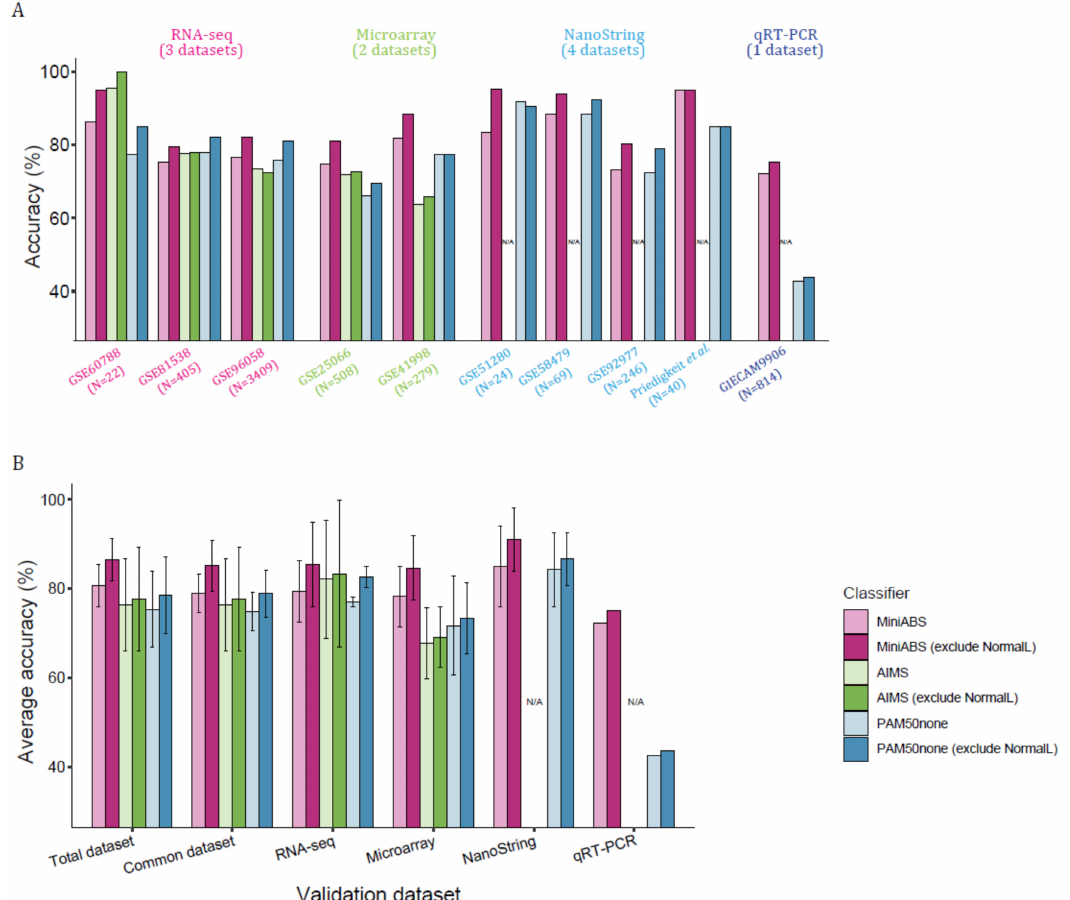
Figure 4. Accuracy in the validation dataset. ( A ) Accuracy in the validation dataset. The numbers in parentheses beneath the datasets correspond to the number of samples. The lack of genes in NanoString and qRT-PCR data prevented the application of AIMS. Bars indicate the accuracy of MiniABS (pink bars), AIMS (green bars), and PAM50none (blue bars). The bars filled with light colors denote the accuracy for the five subtypes, including the Normal-like subtype, and the dark color bars correspond to the accuracy calculated after removing the Normal-like subtype. ( B ) Average accuracy in the validation dataset for the total dataset, common dataset (datasets that could apply to both MiniABS and AIMS classifiers), and each individual platform. Error bars indicate 95% confidence intervals (95%